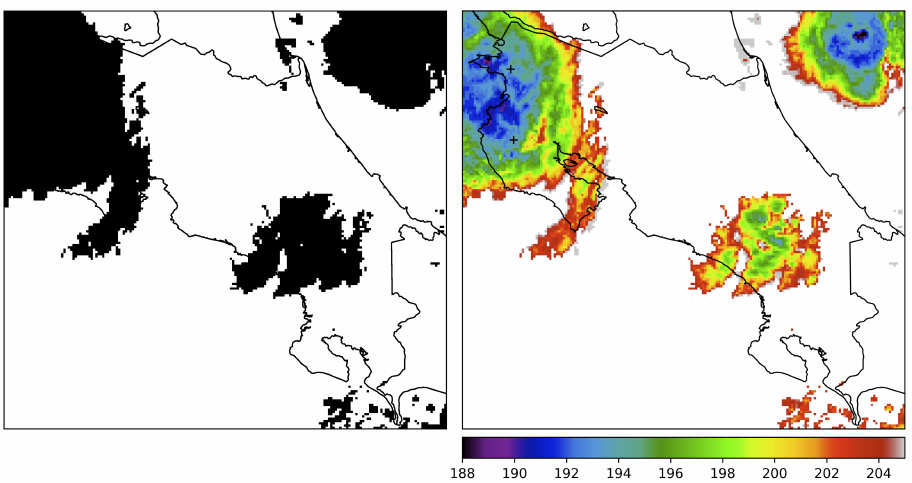
Figure 2. Left Pane . The black areas are generated by the student’s algorithm and correspond to probable intense precipitation. Right Pane . The black areas were used as a mask and applied to Channel 9 to create a derived product useful to